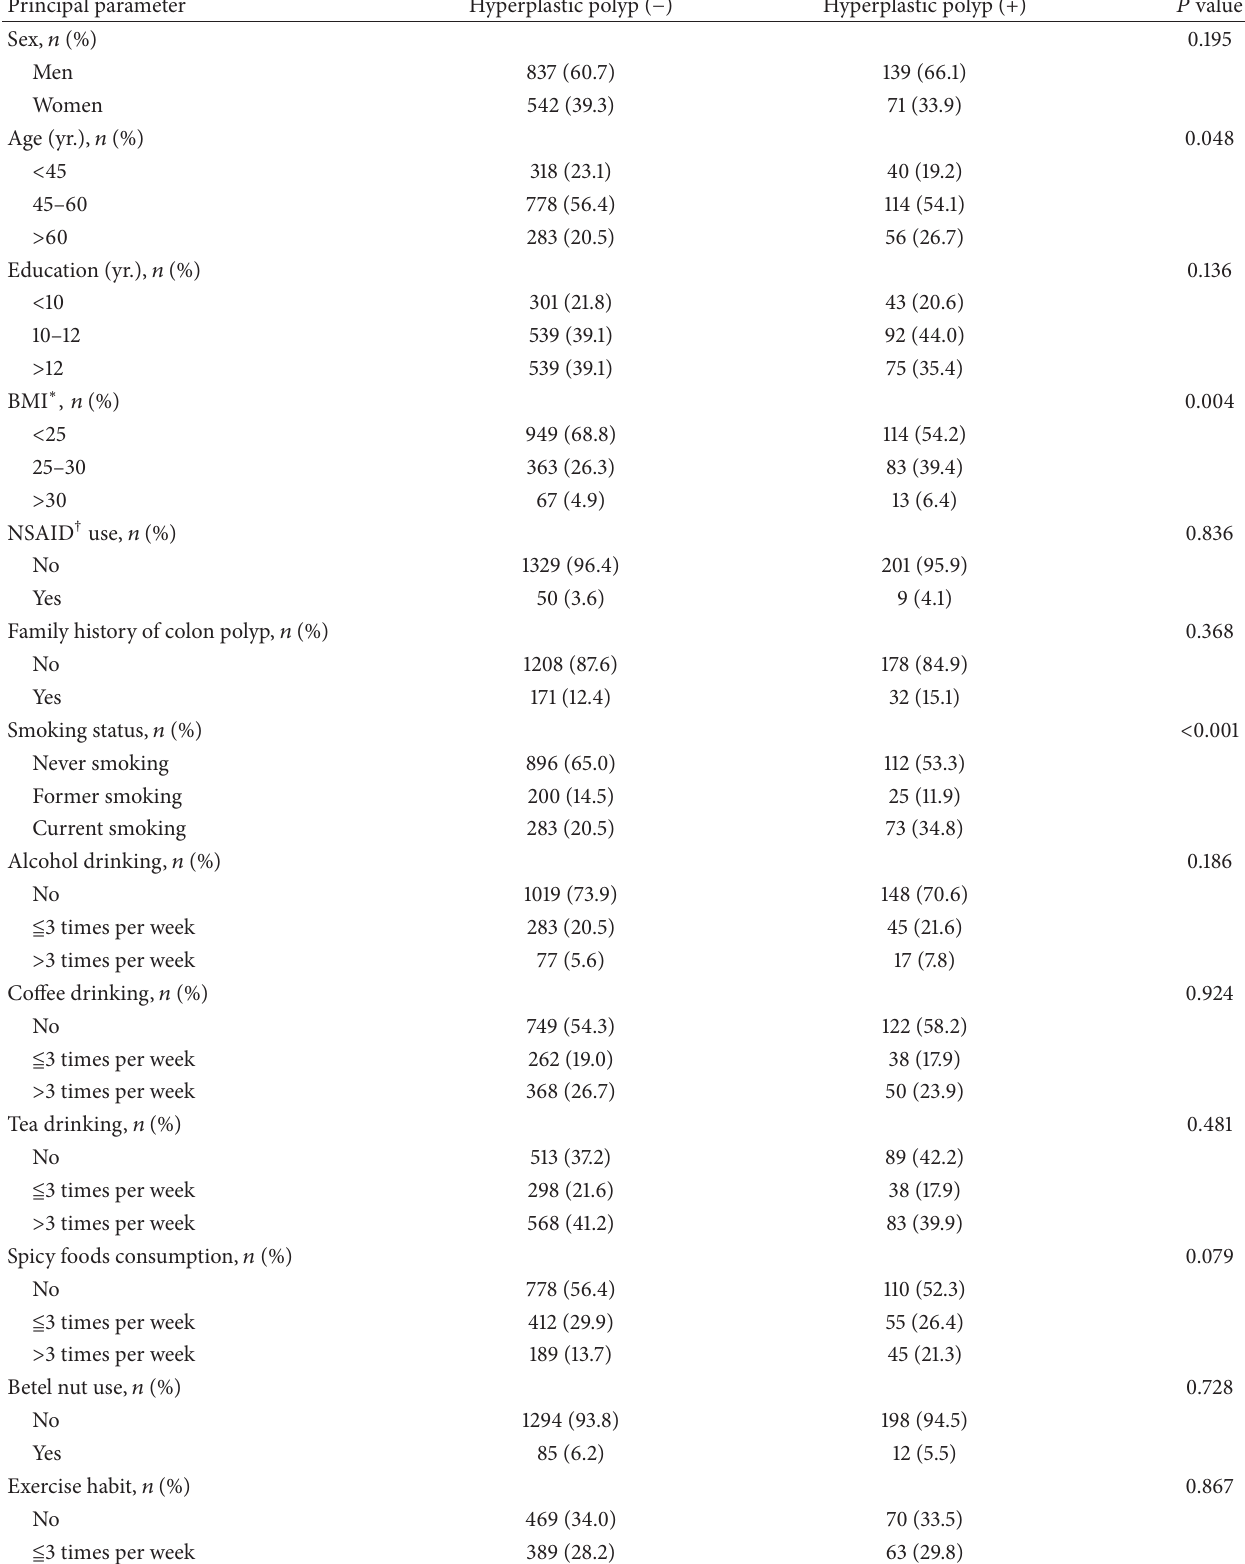
Table 2: Univariate analysis of the risk factors for the development of colorectal hyperplastic